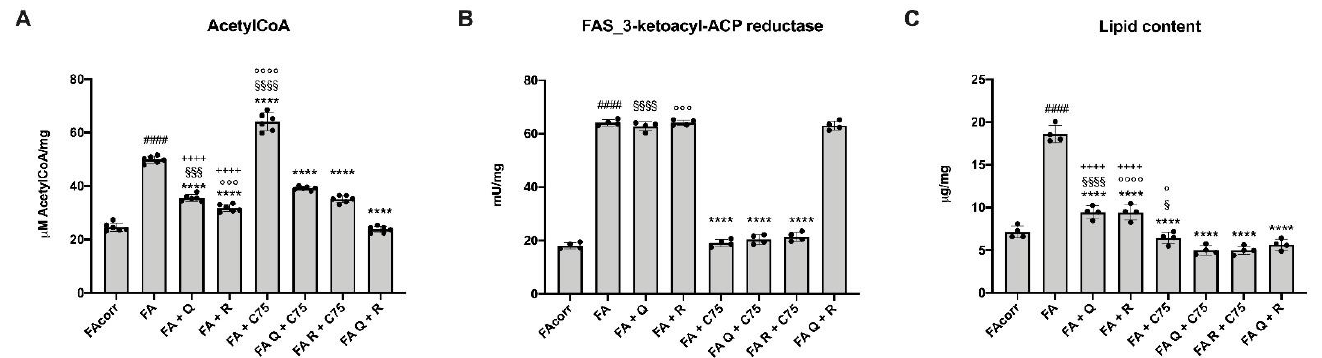
Figure 4. Modulation of fatty acid synthesis and lipid accumulation in FA cells treated with quercetin, rapamycin, and C75, alone or in combination. All data represent experiments conducted after 48 h of drug treatments. ( A ) Acetyl-CoA cellular accumulation. ( B ) 3-ketoacyl-ACP reductase activity, as marker of fatty acid synthesis (FAS). ( C ) Cellular lipid content. (Q = quercetin alone; R = rapamycin alone; C75 = C75 alone; Q + C75 = quercetin/C75 combination; R + C75 = rapamycin/C75 combination; Q + R = quercetin/rapamycin combination). Each graph represents four independent experiments and data are expressed as mean ± S.D. For FA and FA-corr cells, data are representative of four different Fanc-A lymphoblast cell lines. Statistical analysis was performed via one-way ANOVA followed by Tukey multiple comparison test. #### indicates a p < 0.0001 between FA cells and FA-corr cell lines; **** indicates a p < 0.0001 between untreated and treated FA cells. ++++ indicates a p < 0.0001 between treatment with quercetin or rapamycin alone and quercetin/rapamycin combination; §, §§§, or §§§§ indicate p < 0.05, 0.001, or 0.0001 between treatment with quercetin or C75 alone and quercetin/C75 combination; °, °°°, or °°°° indicate a p < 0.05, 0.001, or 0.0001, respectively, between treatment with rapamycin or C75 alone and rapamycin/C75 combination.